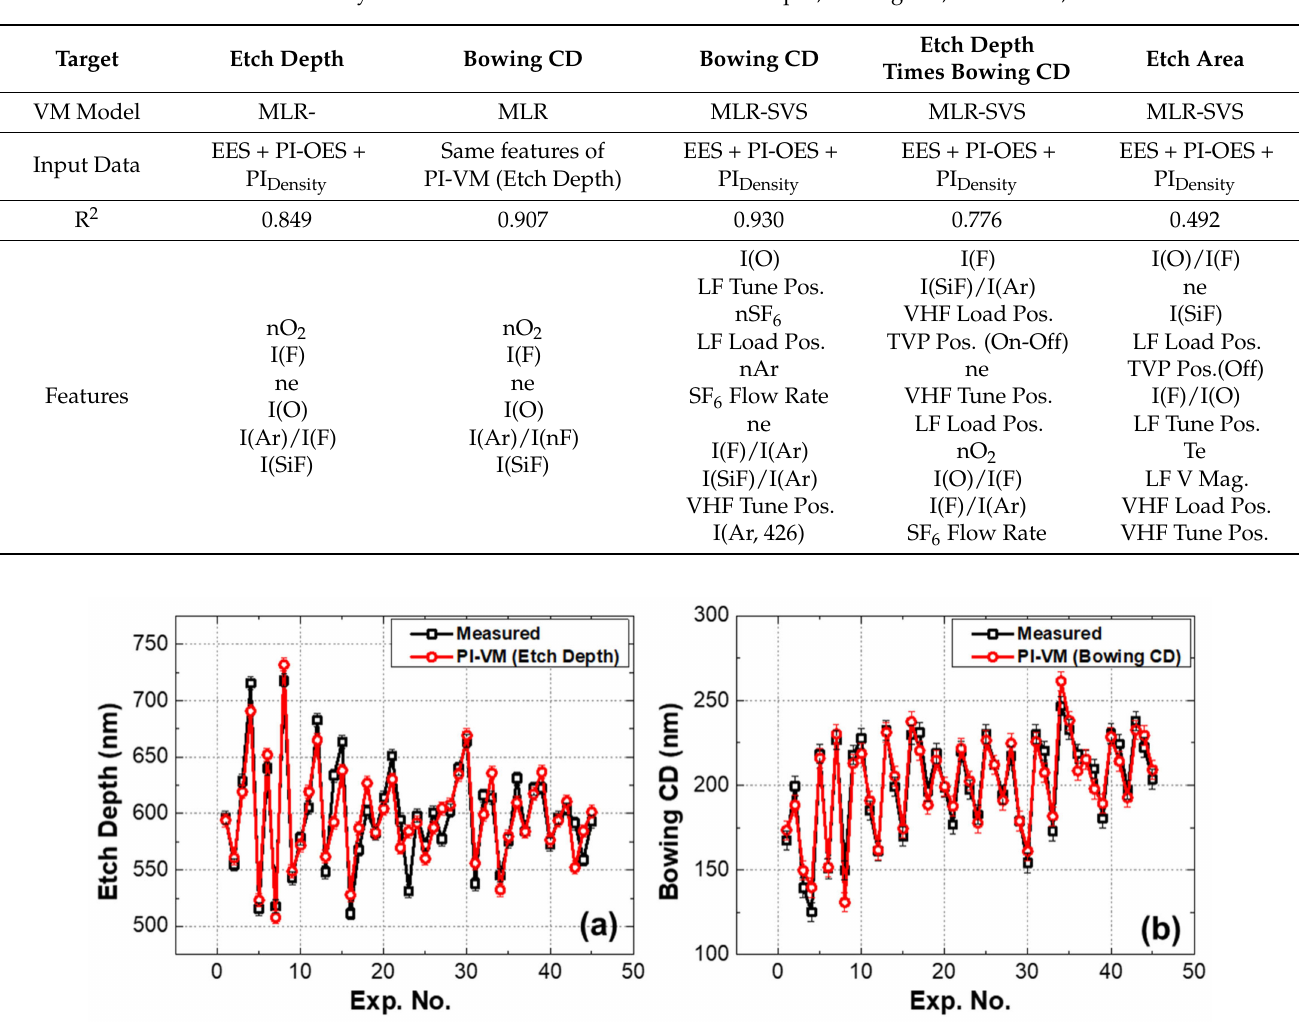
Table 4. Prediction accuracy and features of PI-VM models for etch depth, bowing CD, ED × BCD, and etch area.